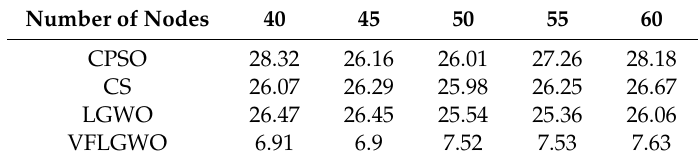
Table 8. Average moving distance with different number of sensor nodes.